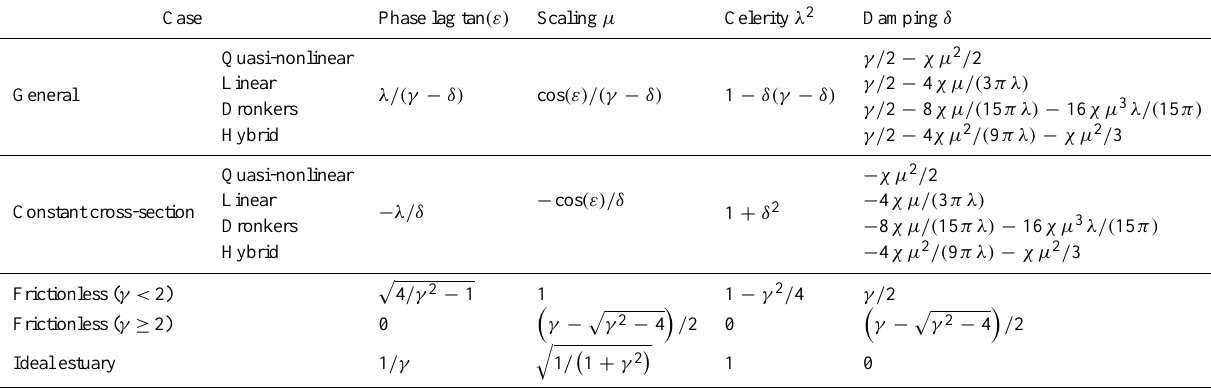
Table 2. Analytical framework for tidal wave propagation (Cai et al.,